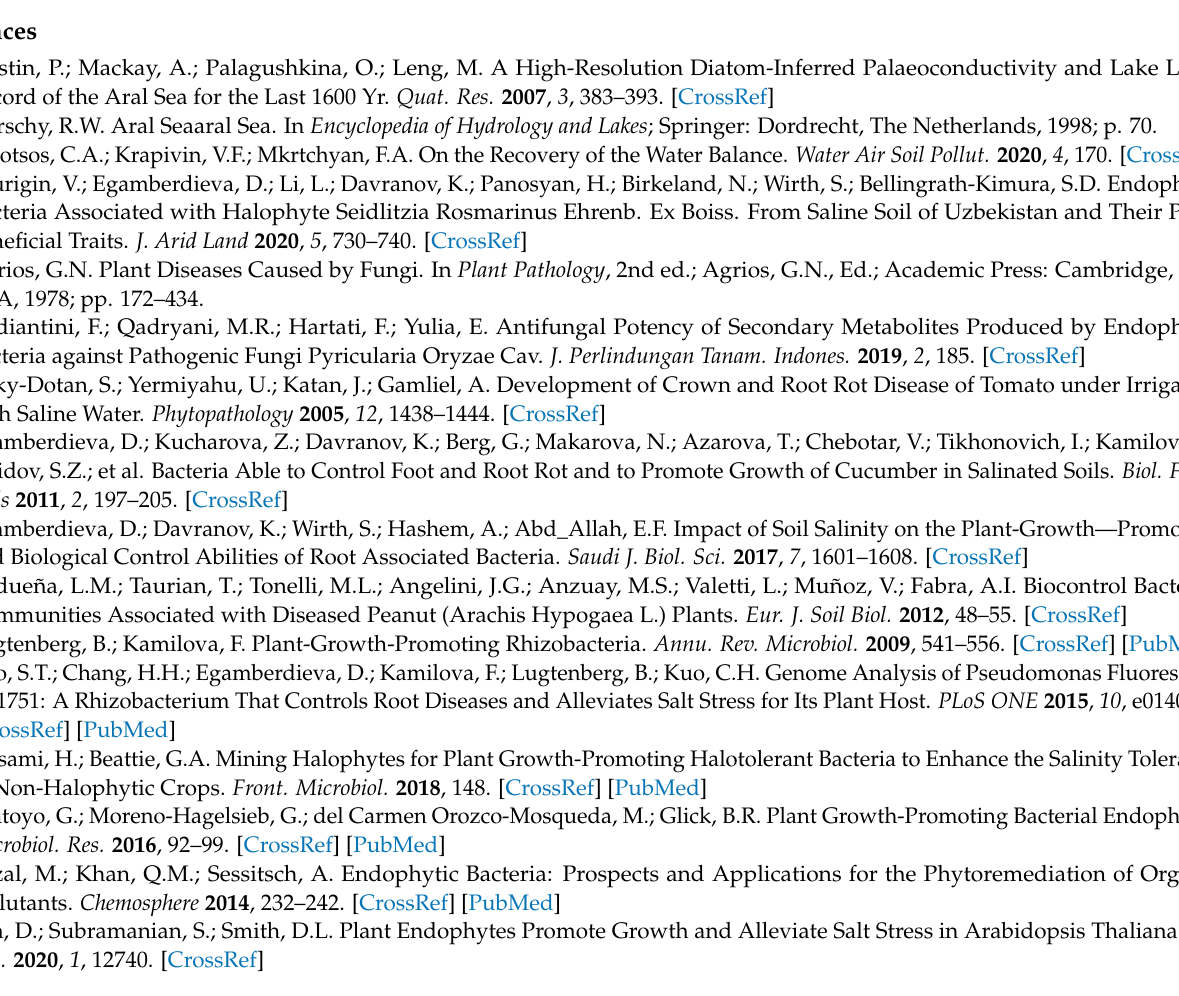
tary Table S2.xlsx, Table S3: Supplementary Table S3.xlsx, Table S4: Supplementary Table